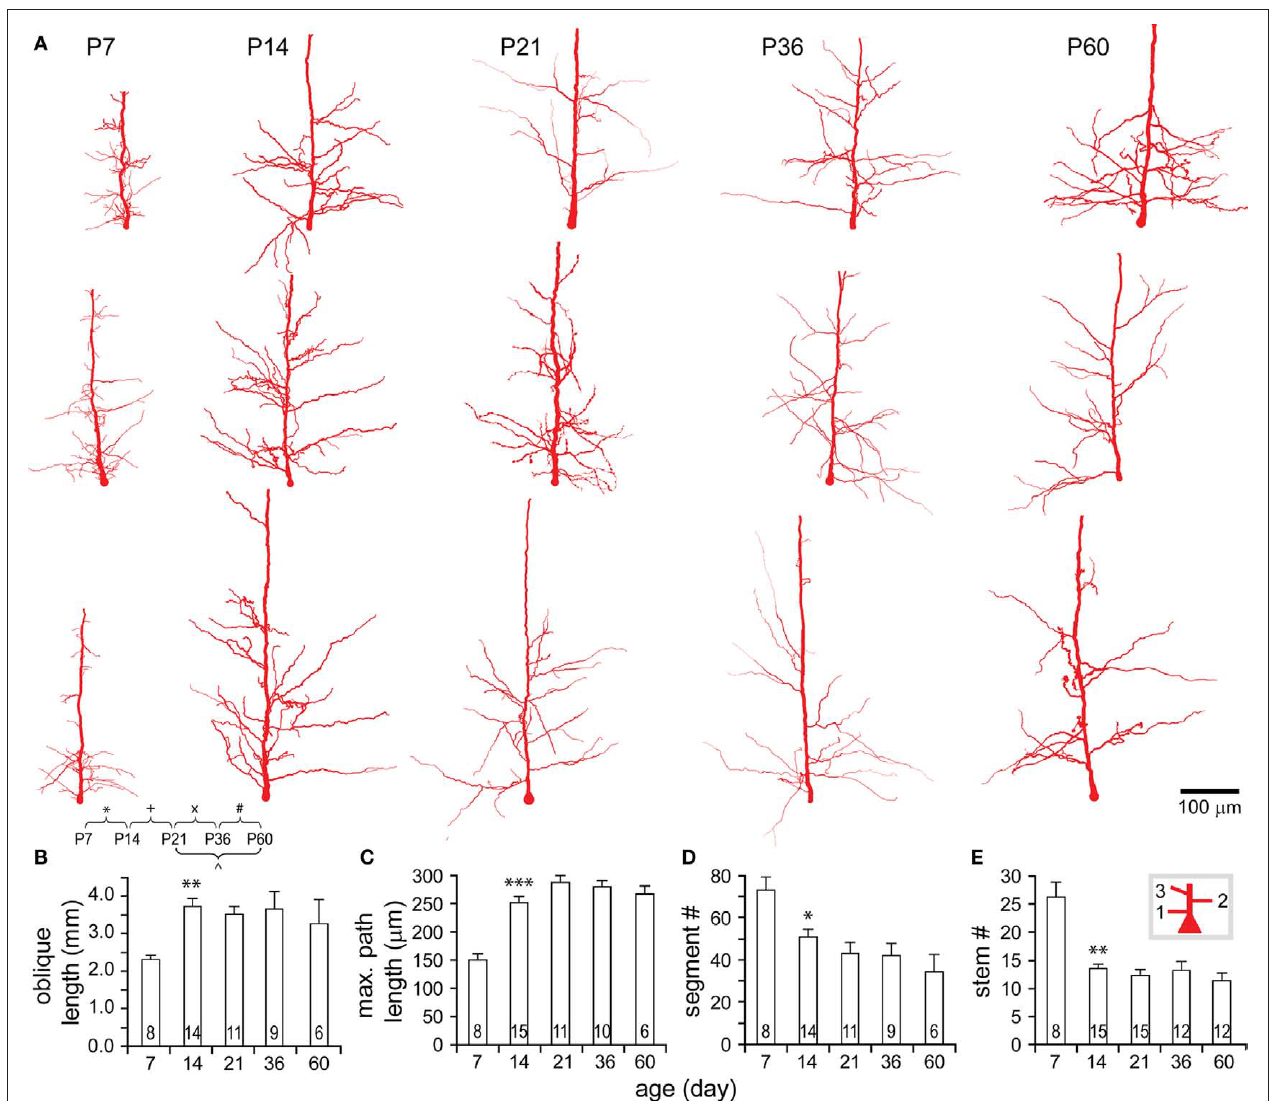
segments (D) , and the number of trees (e) . Significant changes were tested from P7 to P14, including an increase in the total length and the maximal path length, and a decrease in the total number of segments and the number of oblique trees. Thereafter, all these parameters did not show any further significant